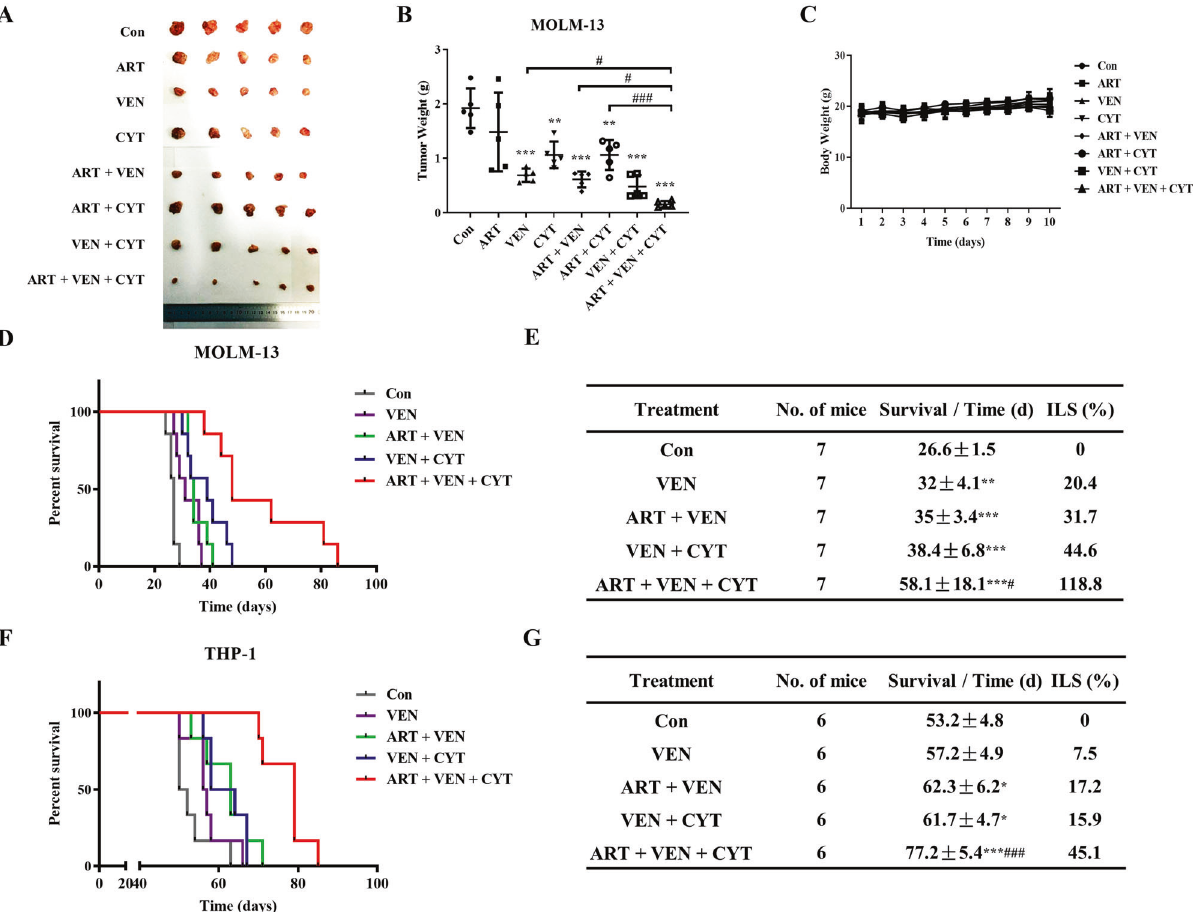
Fig. 7 The triple combination signi fi cantly improves survival of AML xenografts. A Mice inoculated with MOLM-13 cells subcutaneously were treated daily with artesunate (100 mg /kg), venetoclax (100 mg/kg), and cytarabine (50 mg/kg) alone or in combination for 10 days. Tumors were dissected and imaged. B Tumors were weighed and calculated as a percentage of the control. ** P < 0.01; *** P < 0.001 compared to the control group by t -test. # P < 0.05; ### P < 0.001 by two-way ANOVA test. C Mice weights during the treatment. D Kaplan – Meier survival curve of mice inoculated with MOLM-13 cells through the tail-vein. E Average survival time and increase of life span (ILS) of MOLM-13 xenografts. F Kaplan – Meier survival curve of mice inoculated with THP-1 cells through the tail-vein. G Average survival time and ILS of THP-1 xenografts. * P < 0.05; ** P < 0.01; ***, P < 0.001 compared to the control group by log-rank test. # P < 0.05; ### P < 0.001 compared to the venetoclax/cytarabine combination by log-rank test.